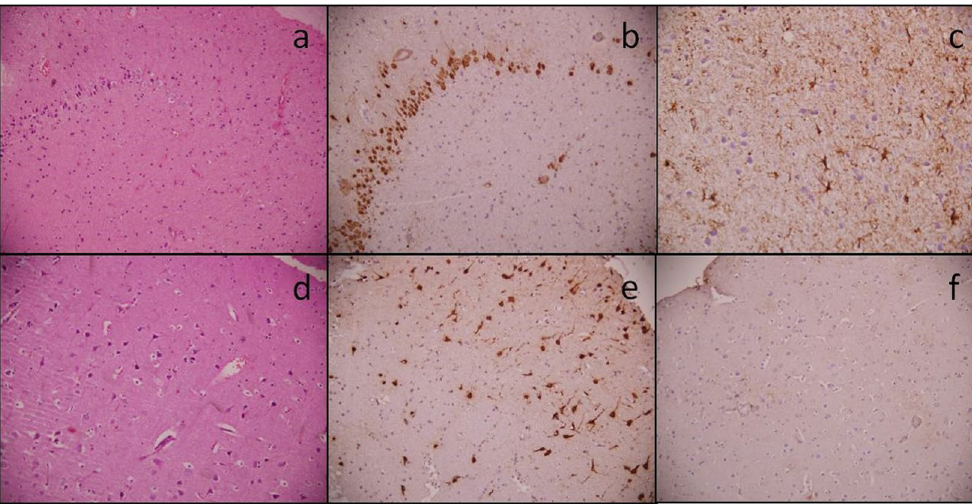
Figure 1. Photomicrographs showing histopathology of the hippocampus and anterior temporal lobe. Representative pictures of the hippocampal specimen showing loss of neurons ( a ) HE, x200) highlighted by Neu N ( b ) IHC, x200), while GFAP shows reactive gliosis ( c ) IHC, x400). Anterior temporal lobe specimens show no loss of neurons ( d ) HE, x200 and ( e ) Neu N IHC, x200) or reactive gliosis ( f ) GFAP IHC,